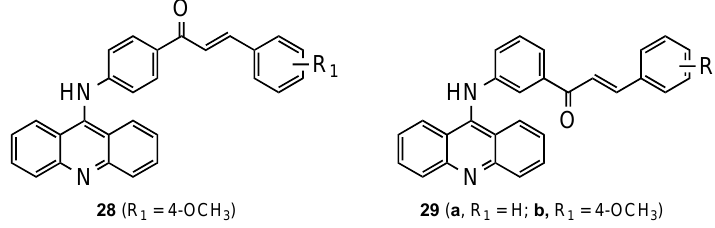
Figure 18. Compounds 28 and 29 developed by Tomar and co-workers [41].